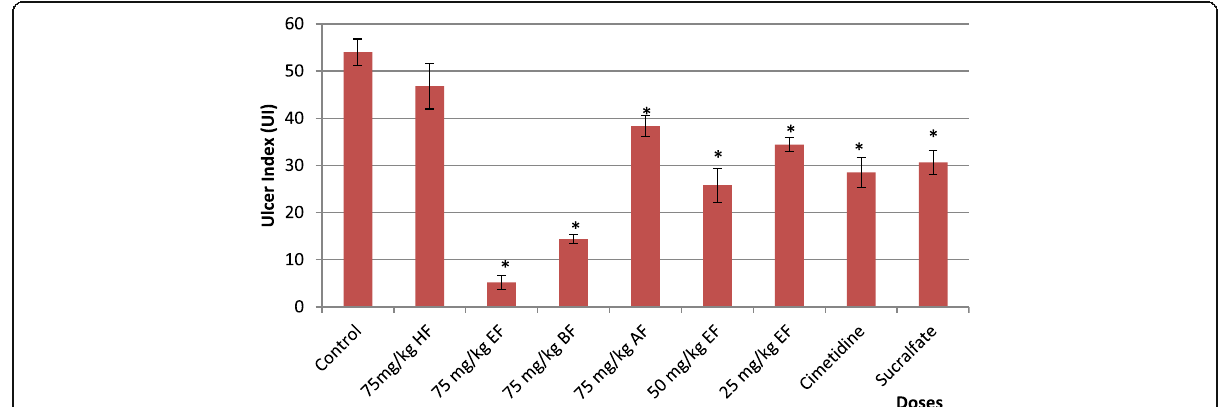
Fig. 1 Effect of fractions of Trichosanthes cucumerina Linn. hot water extract, different doses of ethyl acetate fraction and reference drugs (cimetidine and sucralfate) on ulcer index in ethanol induced gastric ulcers. HF: hexane fraction, EF: ethyl acetate fraction, BF: butanol fraction, AF: aqueous fraction. Values are expressed as mean ± S.E.M., n = 8. * Significant when compared to the control; P ≤ 0.05